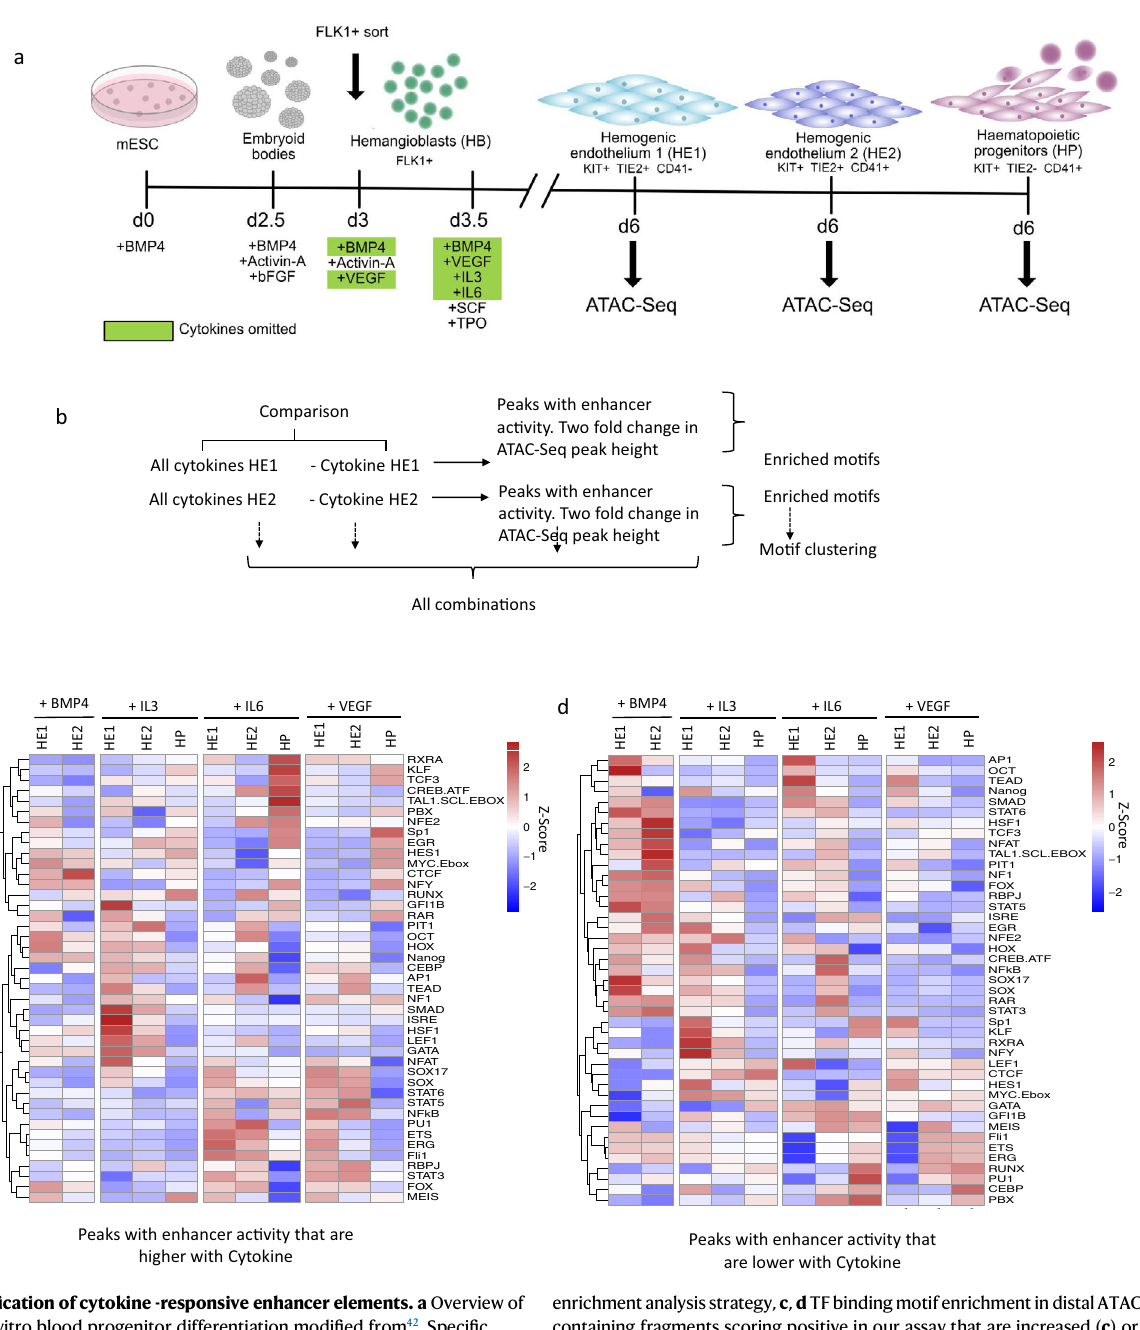
enrichmentanalysisstrategy, c , d TFbindingmotifenrichmentindistalATACpeaks containing fragments scoring positive in our assay that are increased ( c ) or decreased ( d ) at least 2-fold in the presence of the indicated cytokines. Position- weight matrices used for this analysis can be found in Supplementary Table 1 in Supplementary